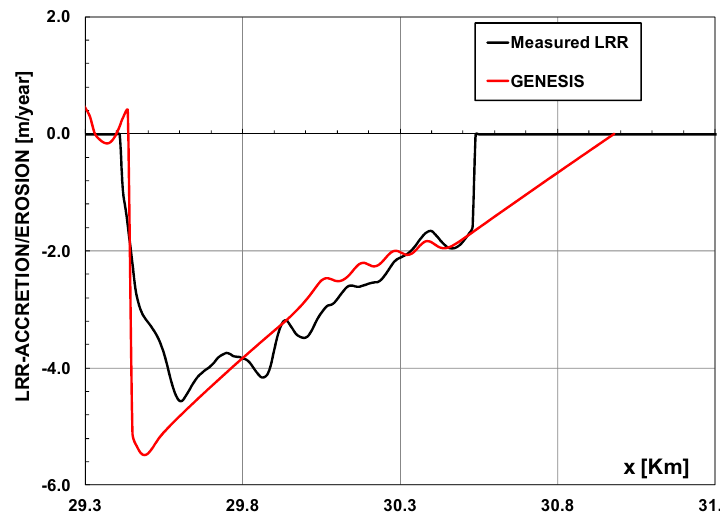
Figure 16. Measured vs. simulated shoreline change rate at E4.